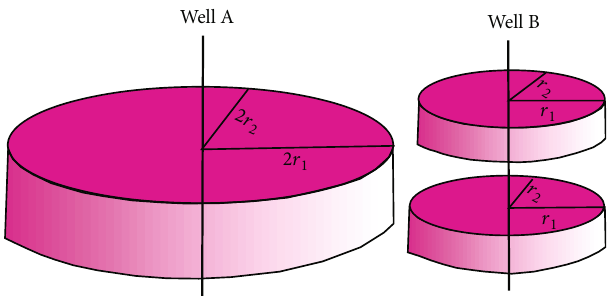
Figure 4: Model of reservoir distribution e ff ects on